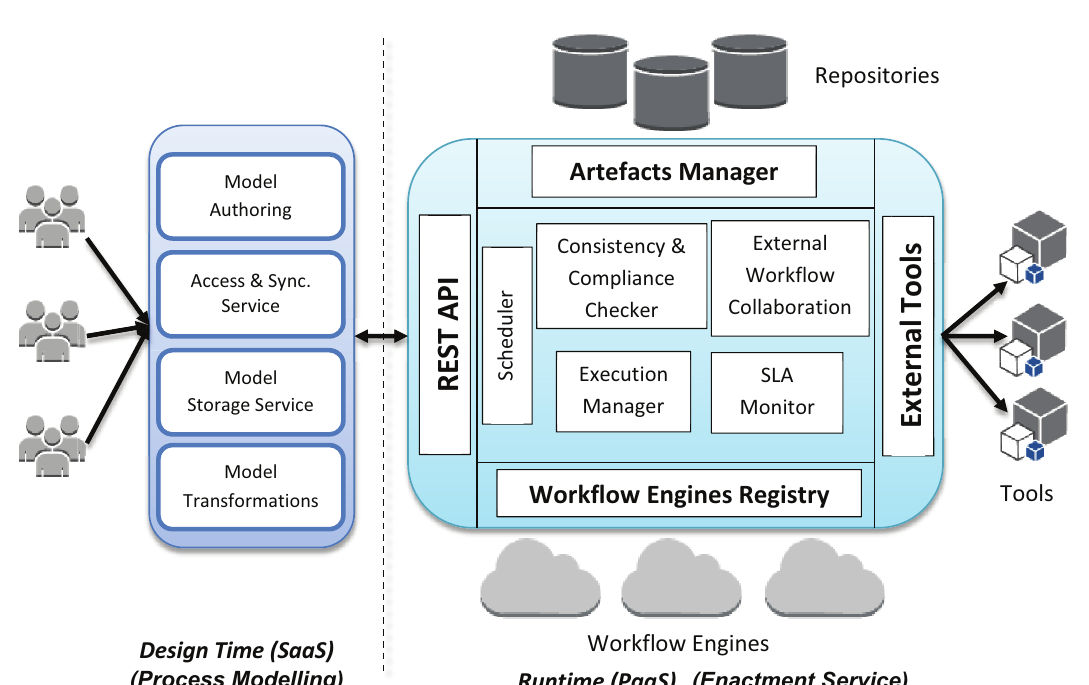
Fig. 1. The SDaaS reference architecture 5